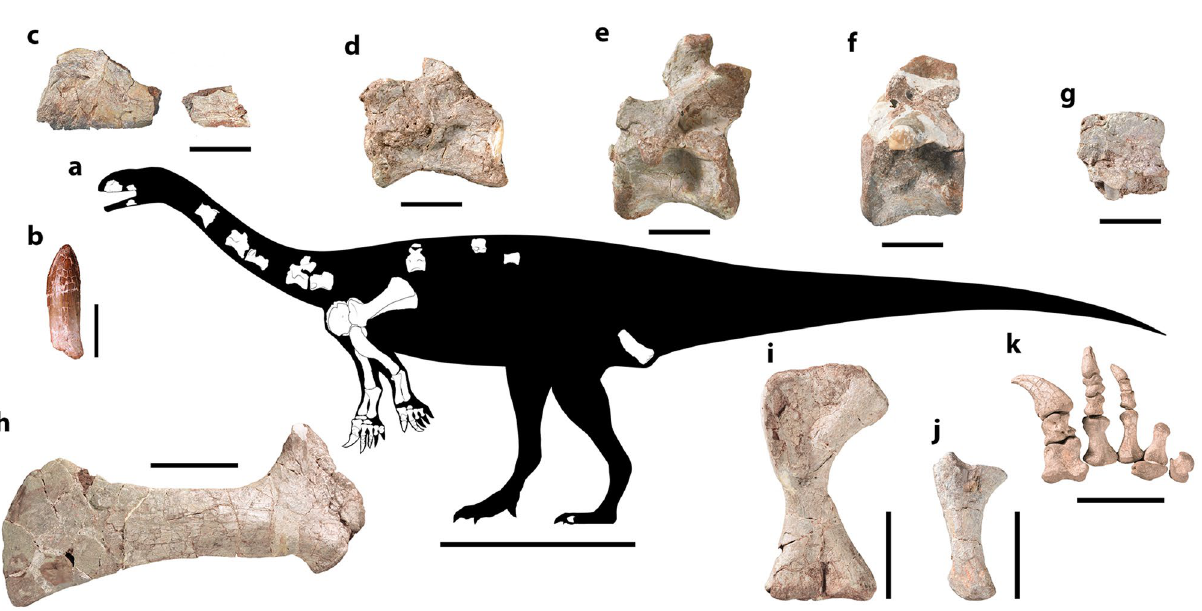
Figure 3. Outline of Irisosaurus yimenensis gen. et sp. nov. displaying the preserved material. The most informative elements are figured. ( a ) Outline; ( b ) Tooth; ( c ) Left maxilla; ( d ) Middle cervical; ( e ) Posterior cervical; ( f ) Anterior dorsal; ( g ) Middle dorsal neural spine; ( h ) Right scapula; ( i ) Right humerus; ( j ) Right ulna; ( k ) Right manus. Scale bars = 1 m ( a );1 cm ( b ); 5 cm ( c–g ); 10 cm ( h–k